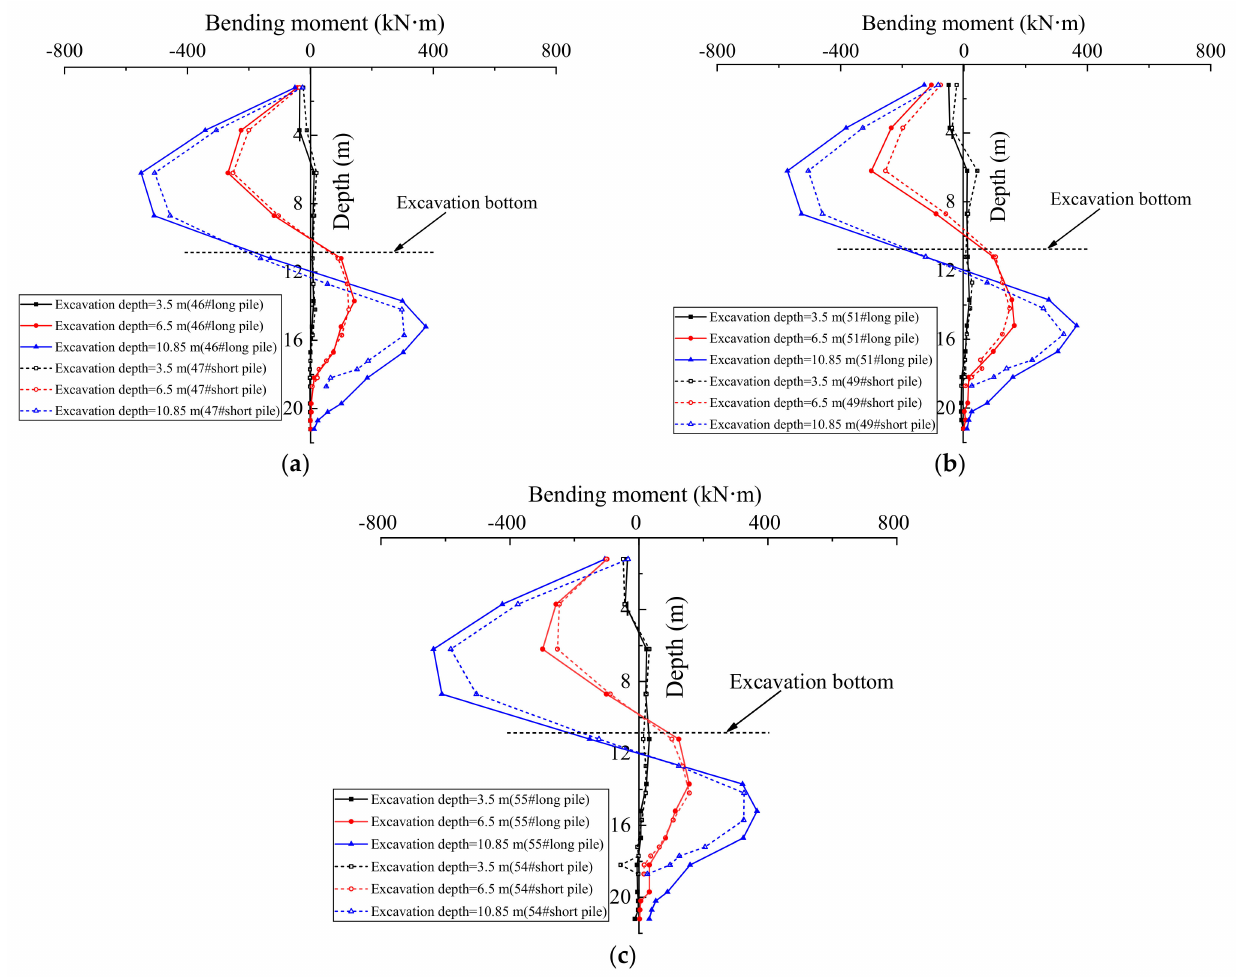
Figure 7. Bending moment of the pile during excavation: ( a ) combination 1; ( b ) combination 2; ( c ) combination